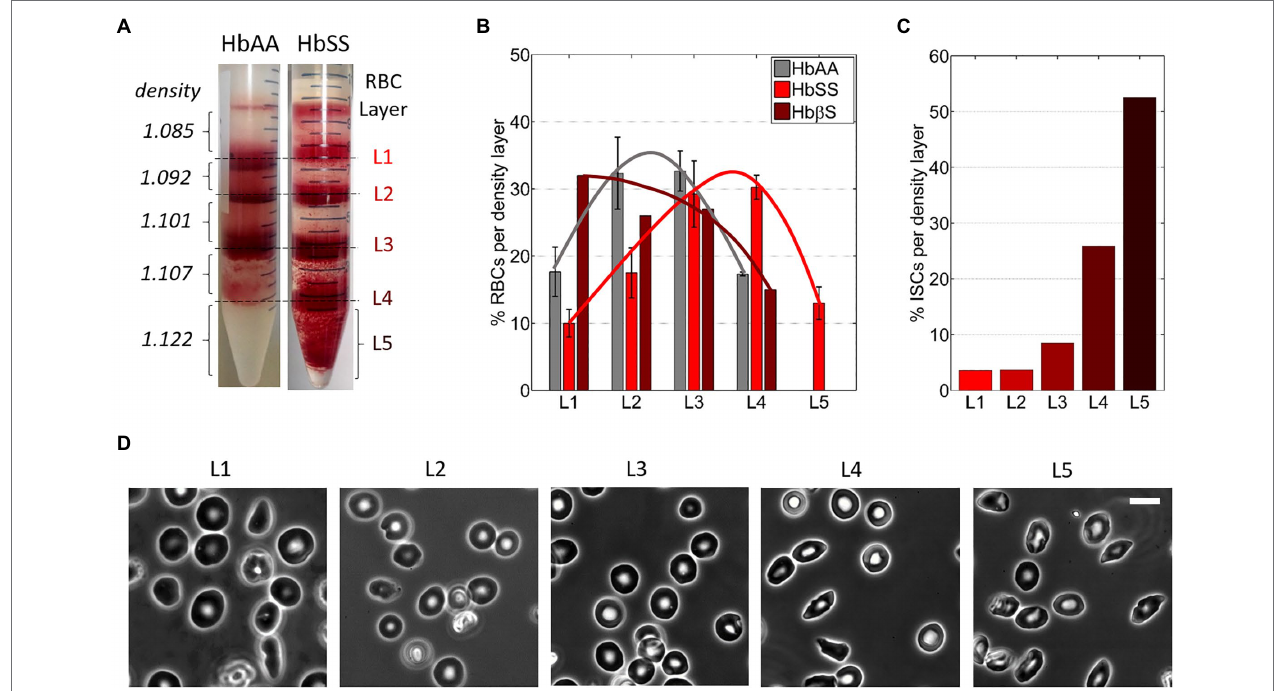
FIGURE 2 | RBCs from Sickle Cell Disease patients are denser. (A) Typical images of RBC layers from healthy (HbAA) and SCD (HbSS) blood samples after sorting in discontinuous Percoll gradients of increasing densities d . (B) Relative content in RBCs for the five density layers in various blood samples: HbAA (averaged over three samples); HbSS (averaged over three samples); Hb β S (one sample). The lines are guides to the eyes. (C) Percentage of irreversible sickle RBCs (ISCs) per density layer for an HbSS patient (calculated over ≈ 300 RBCs per density layer). (D) Typical 100× phase-contrast images of RBCs in each of the five layers in the same HbSS patient. Scale bar: 10 μ